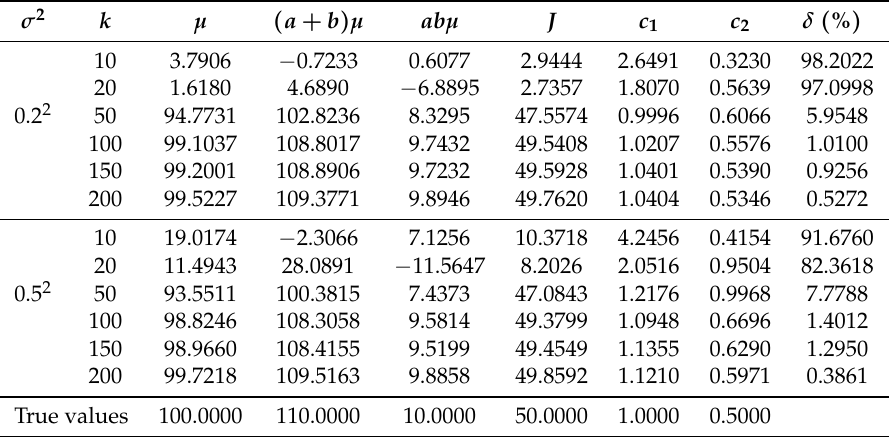
Table 1. The RLS estimates and errors.